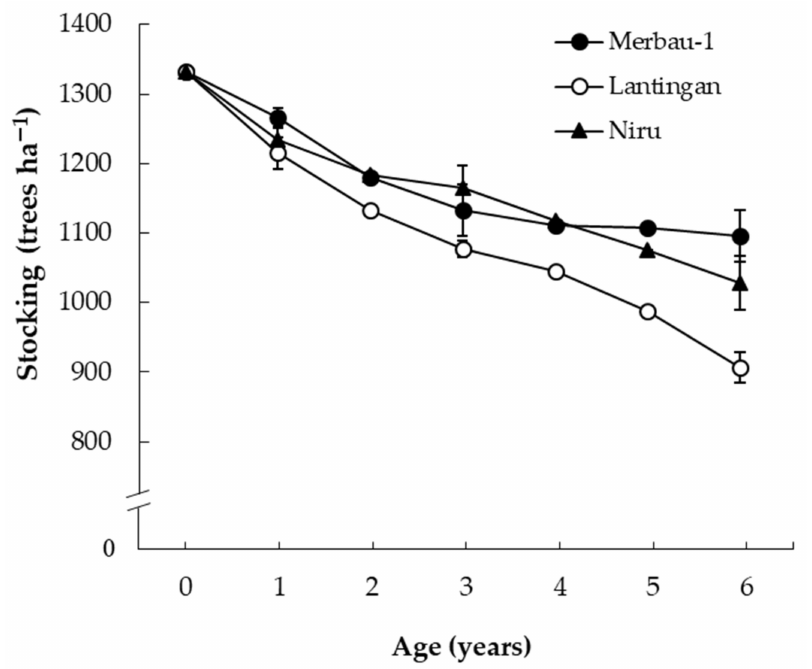
Figure 6. Changes in stocking (trees ha − 1 ) of Eucalyptus pellita from planting to harvest at sites representing three levels of productivity: high (Merbau-1), medium (Lantingan) and low (Niru). Vertical bars are SE of means of four replications. Data was from pooled-data of added P